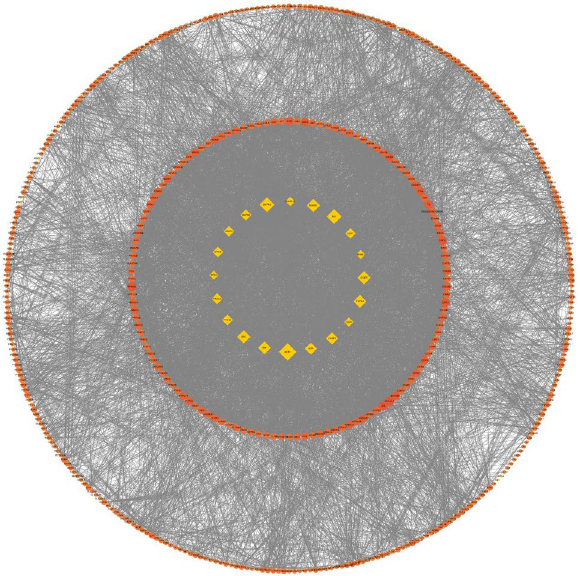
Figure 6. Compound-target-pathway network. Red hexagonal nodes represent pathways, blue rectangle nodes represent targets, yellow circle nodes represent AR, and green circle nodes represent